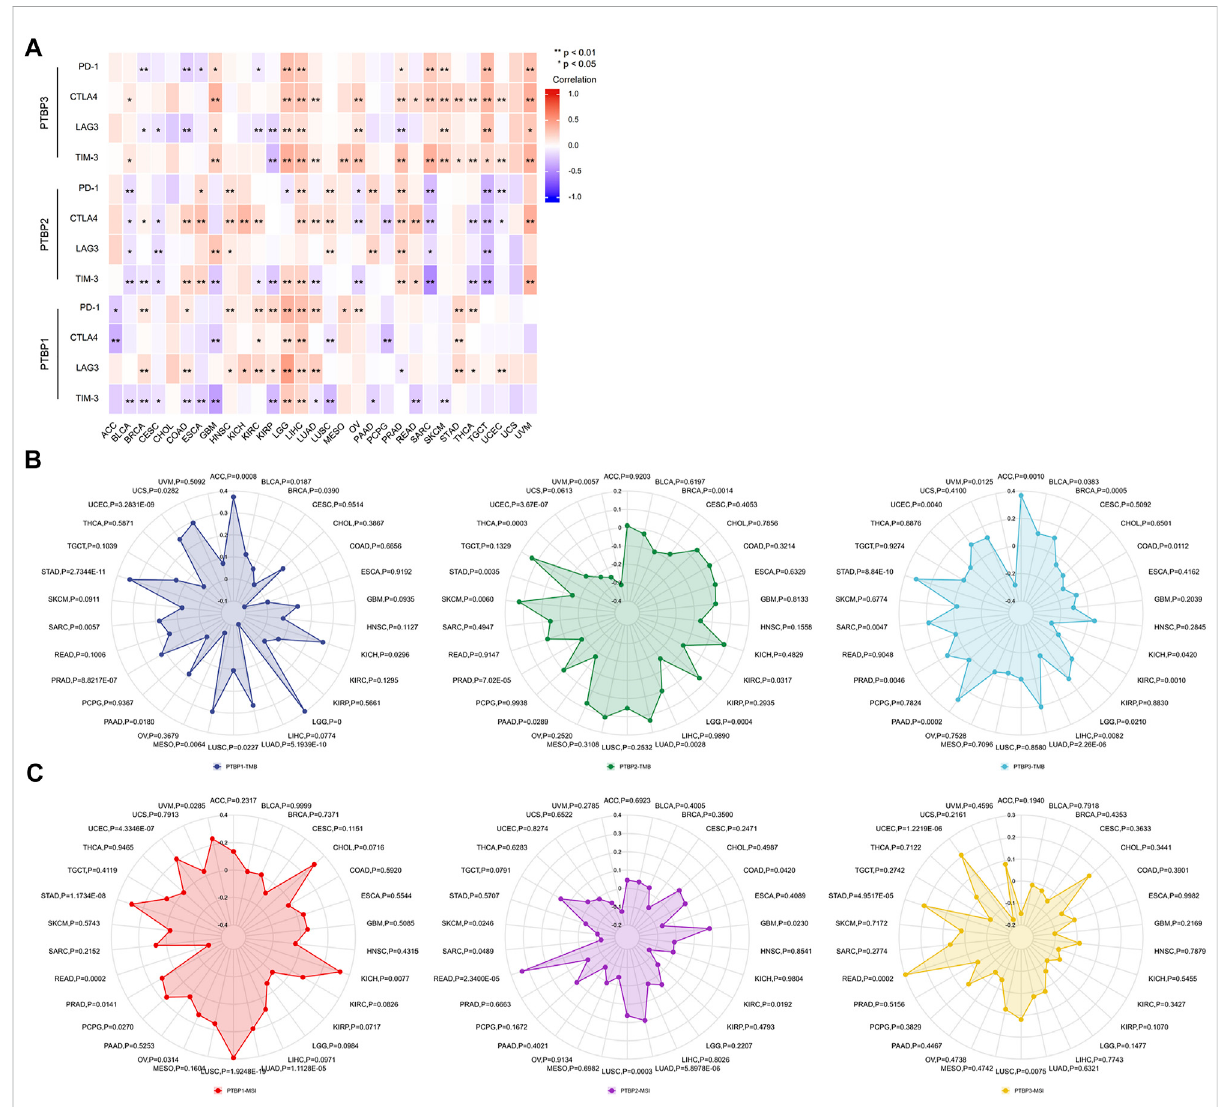
FIGURE 7 Spearman correlation analysis of PTBP expression with immune checkpoint genes, tumor mutational burden and microsatellite instability in pan-cancer. (A) Correlation of PTBP expression with ICPs (PD-1, CTLA4, LAG3 and TIM-3) in pan-cancer (* p < 0.05; ** p < 0.01). (B) Correlation of PTBP expression with TMB. (C) Correlation of PTBP expression with MSI. p values are marked in the fi